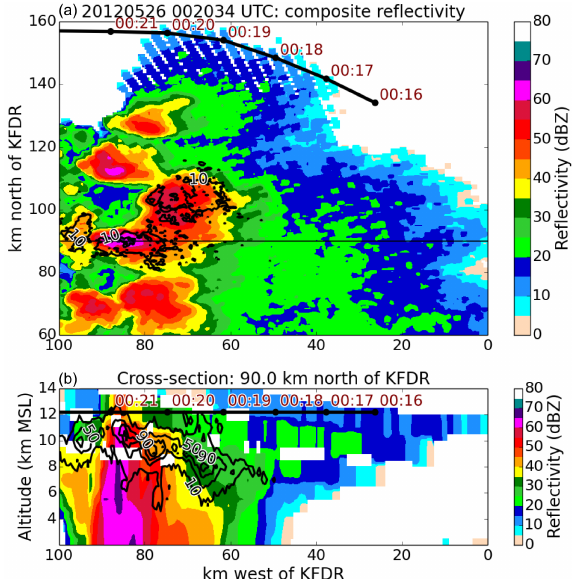
Figure 12. As in Fig. 10, except for the stronger southern cell at 00:20:34. Also, the G-V flight track in plan view and cross-section for several minutes near 00:20:34 is indicated by the thick black line. The G-V position at every minute is indicated by the black dots along the line, and UTC times along the track are labeled in brown.